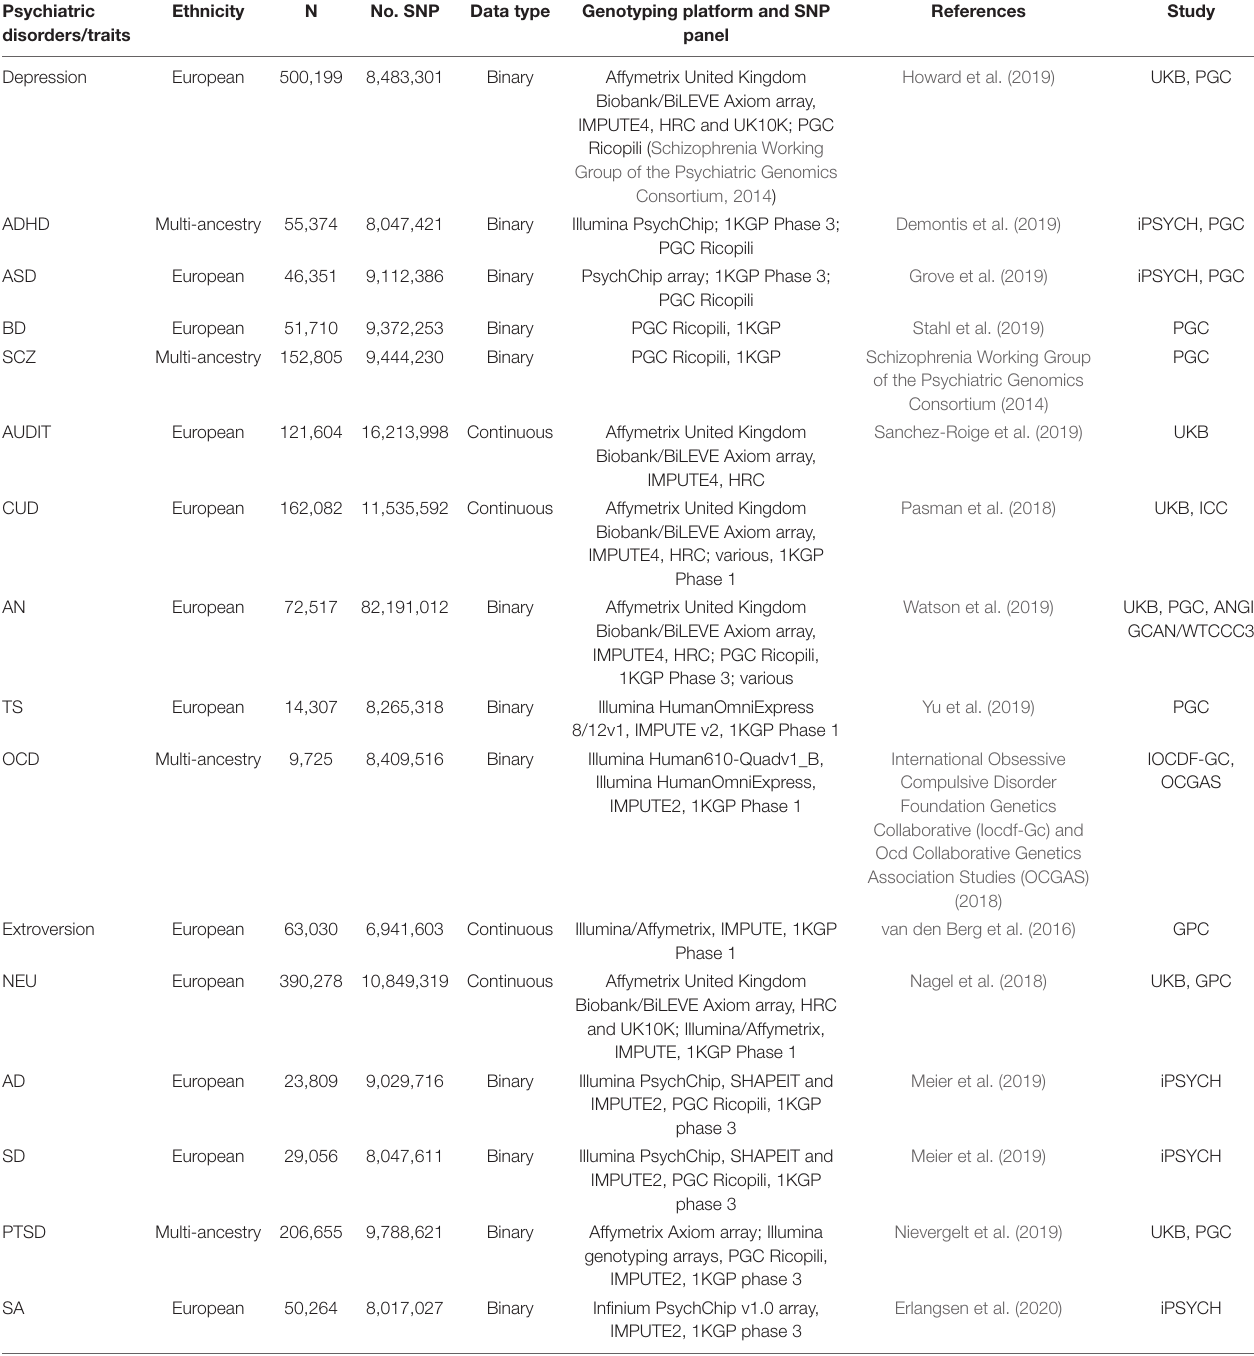
TABLE 1 | Characteristics of included genome-wide association studies for psychiatric disorders. Psychiatric